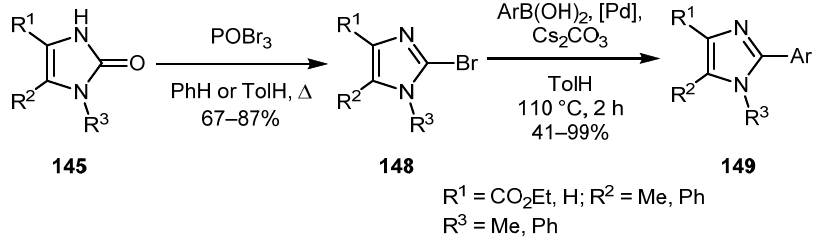
Scheme 33. Derivatization of 2-imidazolones in solution- and solid-phase.